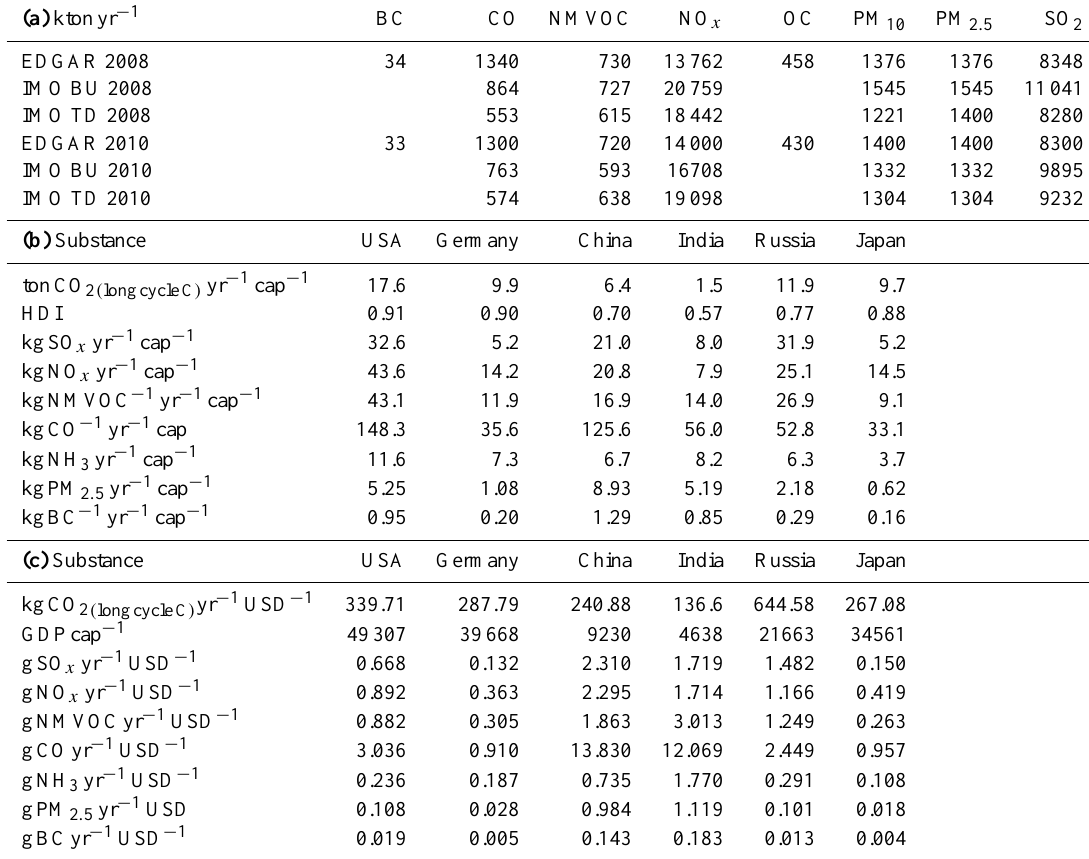
Table 2. (a) Comparison of the international shipping emissions: IMO bottom-up (BU) and IMO top-down (TD) emissions of the IMO (2014) study and the EDGAR emissions of the HTAP_v2.2 (2015) study. (b) Per capita emissions in 2010 for USA, Germany, China, India, Russia and Japan from HTAP_v2.2. (c) Emissions per unit of GDP in 2010 for USA, Germany, China, India, Russia and Japan from